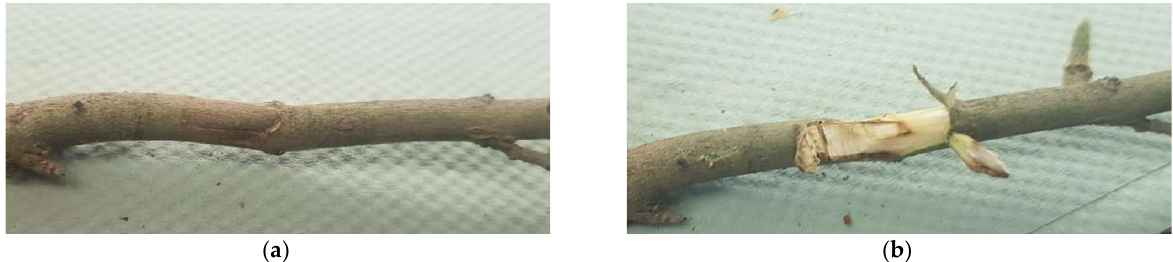
Figure 3. Samples of saplings sprayed with BTHWA prior to inoculation (S2) in general view ( a ) and cross section ( b ).